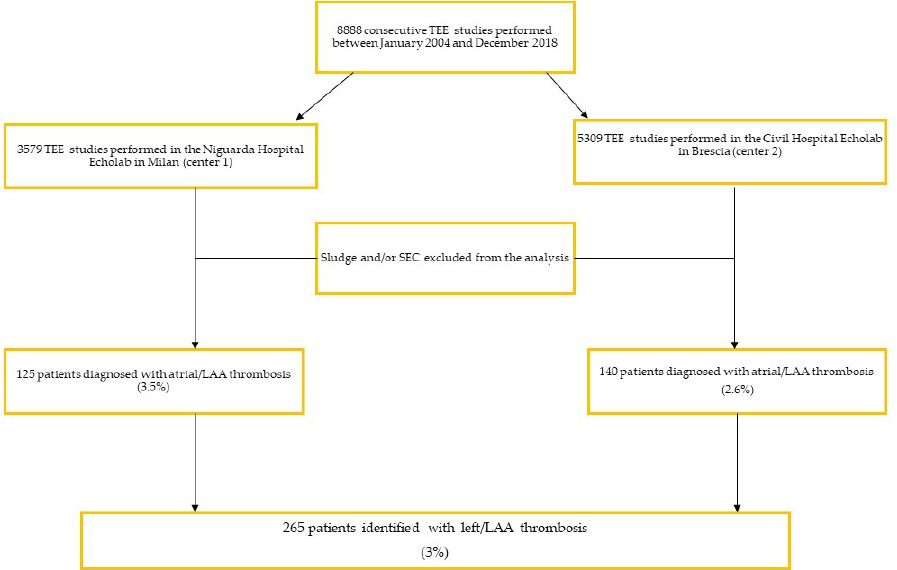
Figure 1. Diagram of the study. EE: transesophageal echocardiogram; SEC: spontaneous echo contrast; LAA: left atrial appendage.